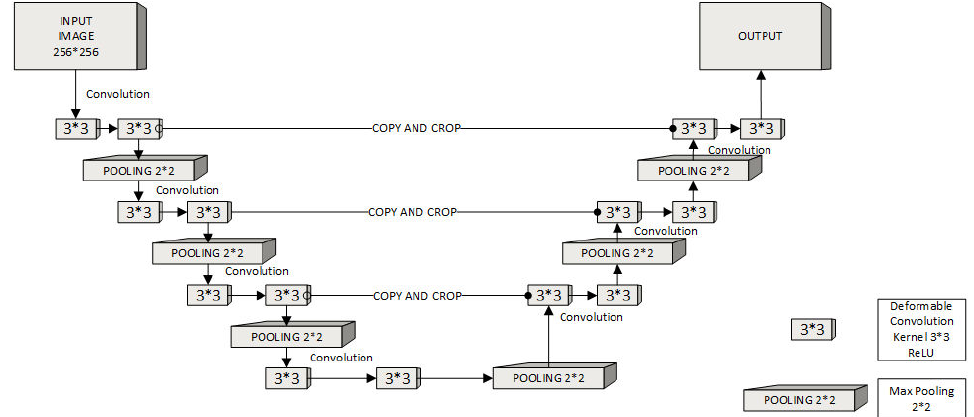
Figure 14. Convolution neural network